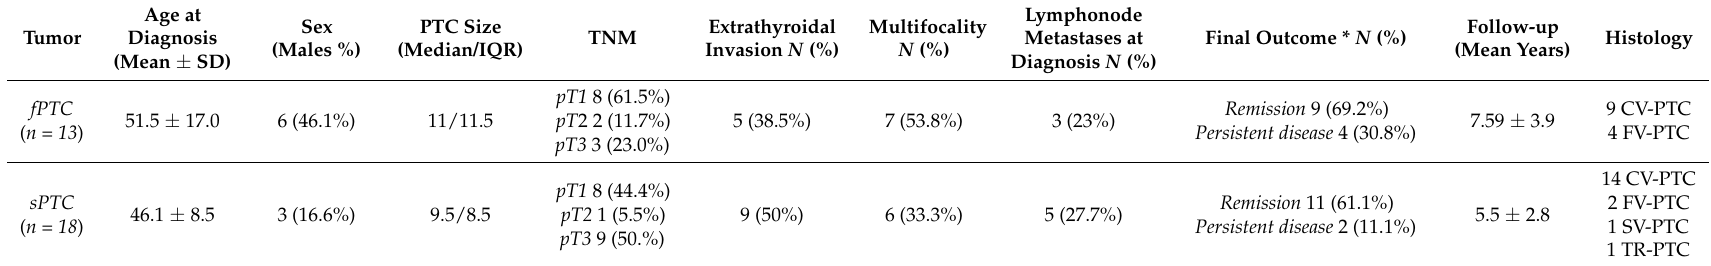
Table 1. Characteristics of